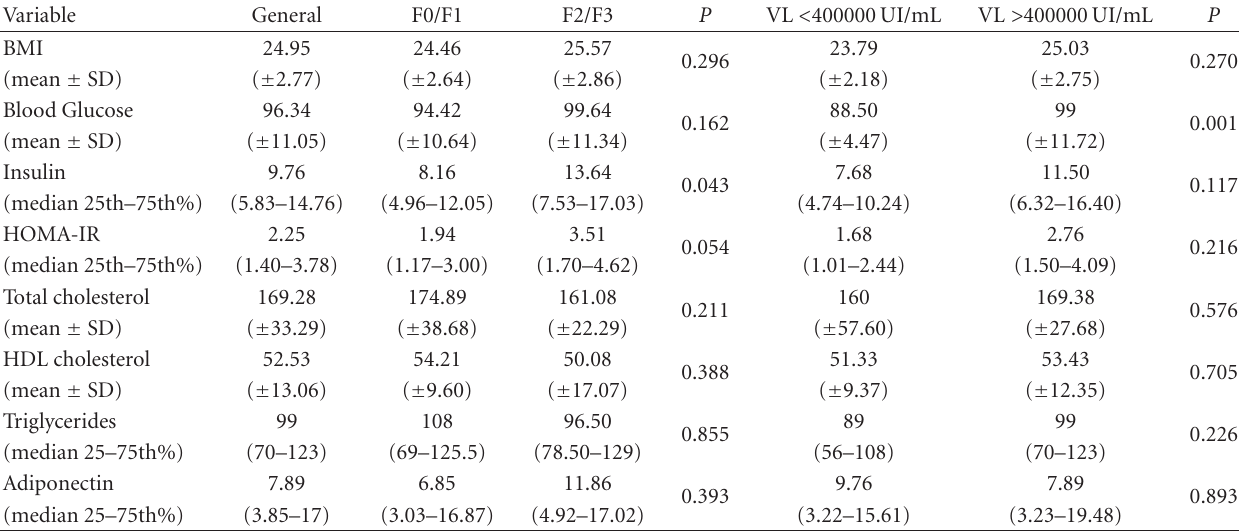
Table 1: Glycemic and lipid profiles of patients with chronic hepatitis C and its correlation with viral load and fibrosis.